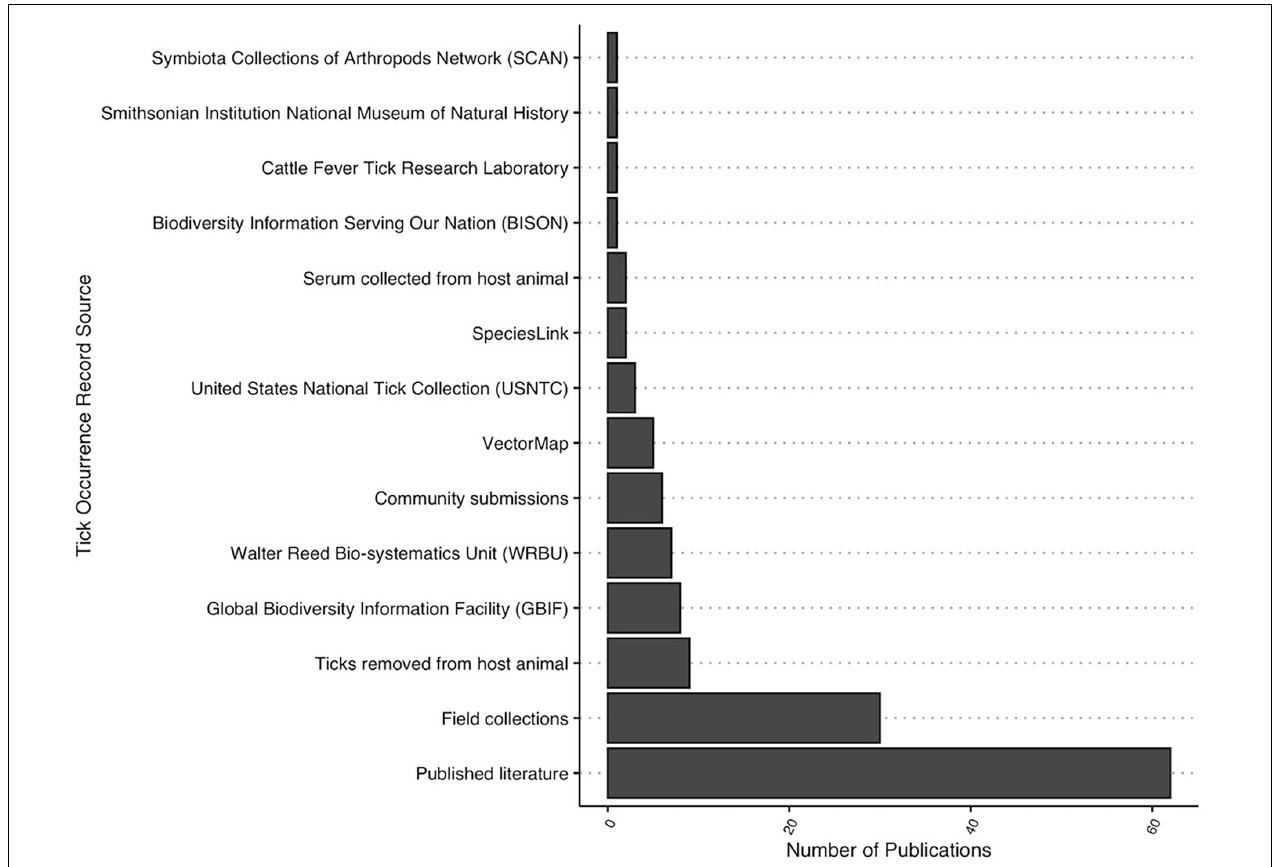
FIGURE 4 | Sources ( n = 14) of tick occurrence data reported within included distribution modeling